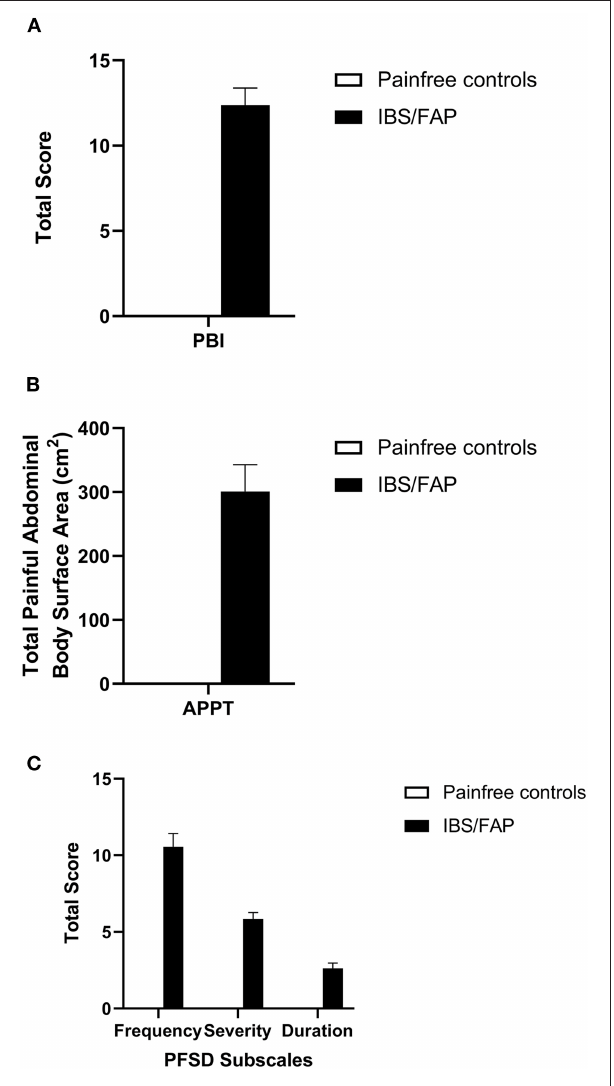
TABLE 1 | Patient cohort descriptive statistics and clinical survey